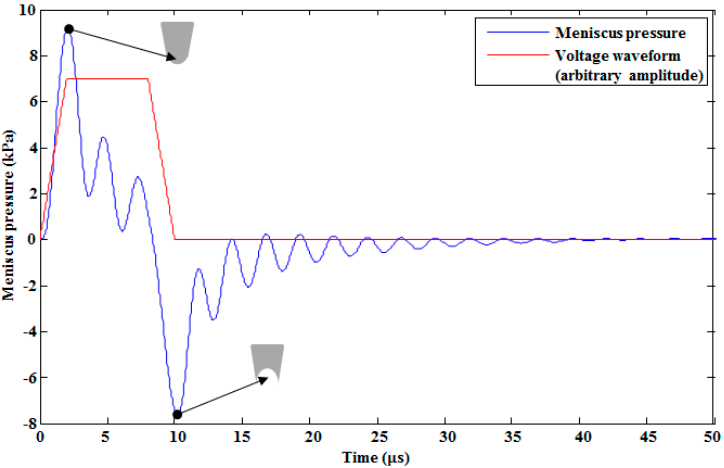
Figure 7. Meniscus pressure on the rising and falling edges of the voltage waveform.